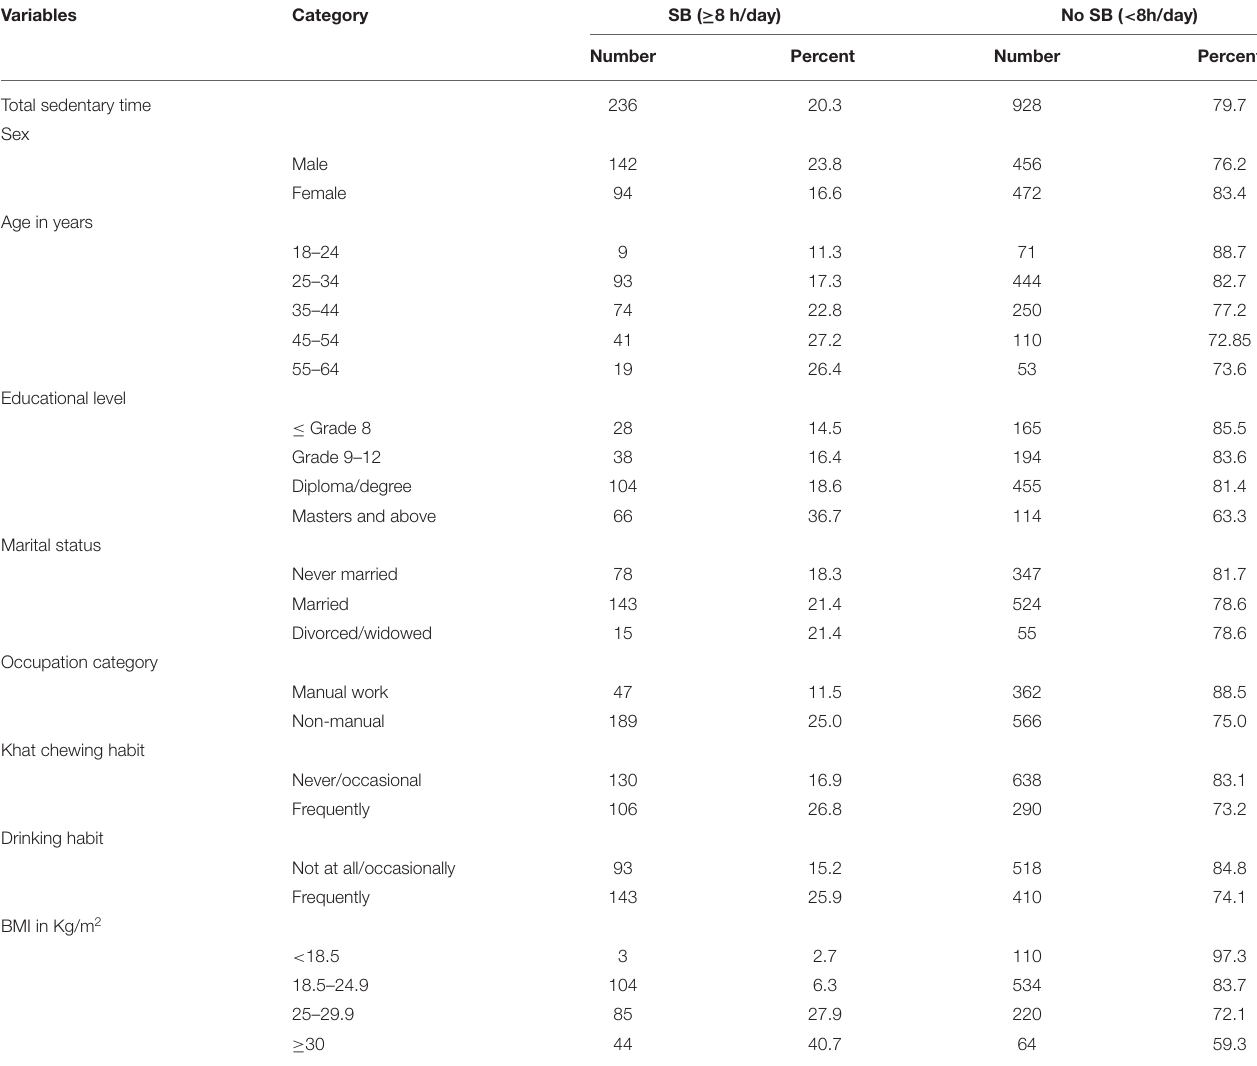
TABLE 5 | Prevalence of high sedentary behavior by characteristics of study participants in Eastern Ethiopia, 2019 ( n = 1,164). Variables